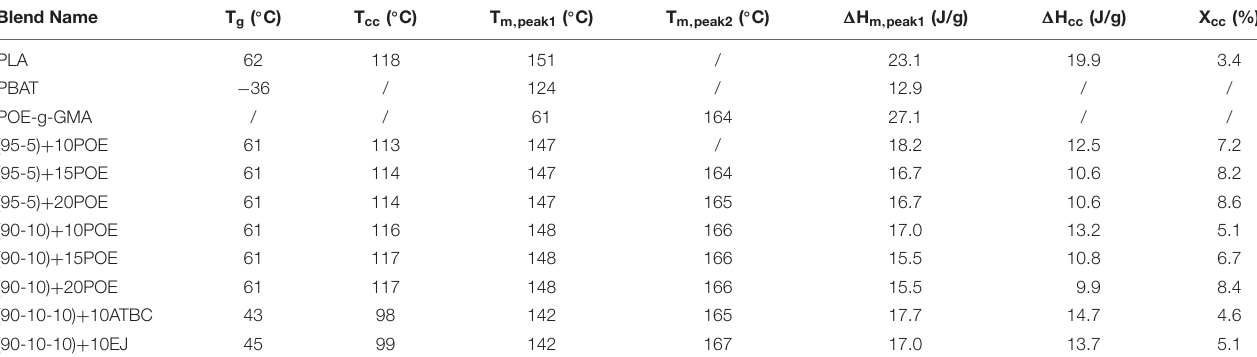
TABLE 5 | Main thermal properties taken from DSC second run for samples heated at 10 ◦ C/min.